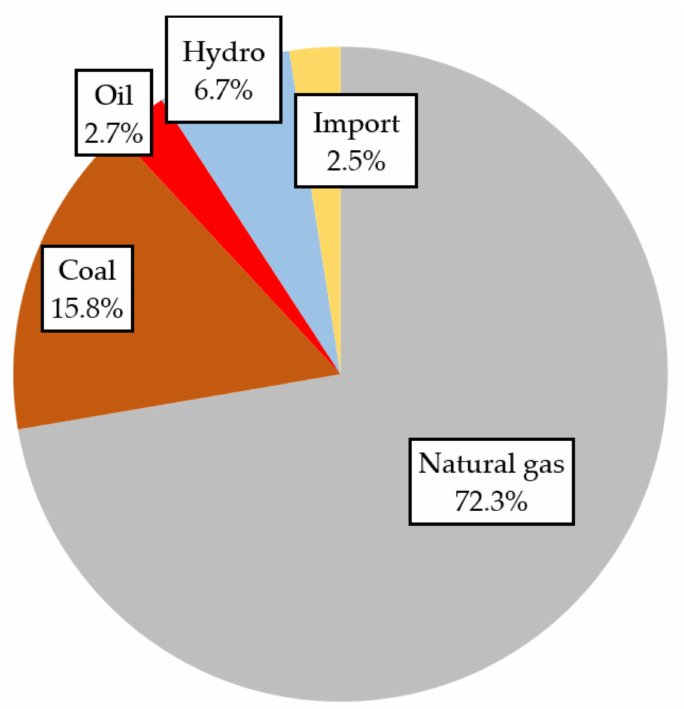
Figure 1. Sources of electricity consumed in Thailand. Source: US Energy Information Administration (2019) as cited in [29].